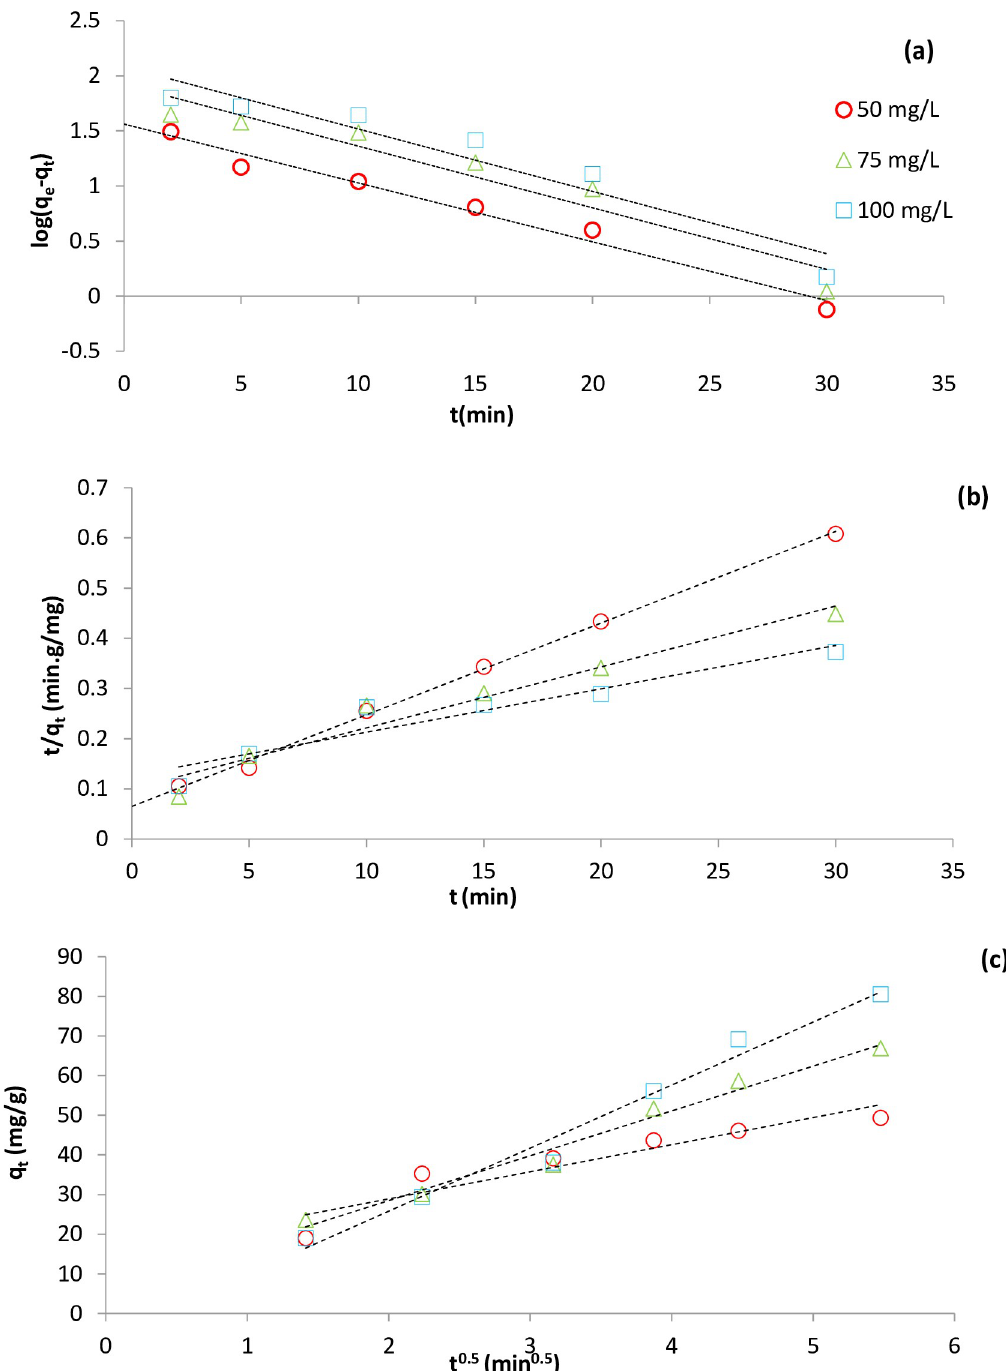
Fig 7. Linear plots of kinetic models used for adsorption of CIP (a) Pseudo- first order, (b) Pseudo- second order and (c) Intra-particle diffusion.